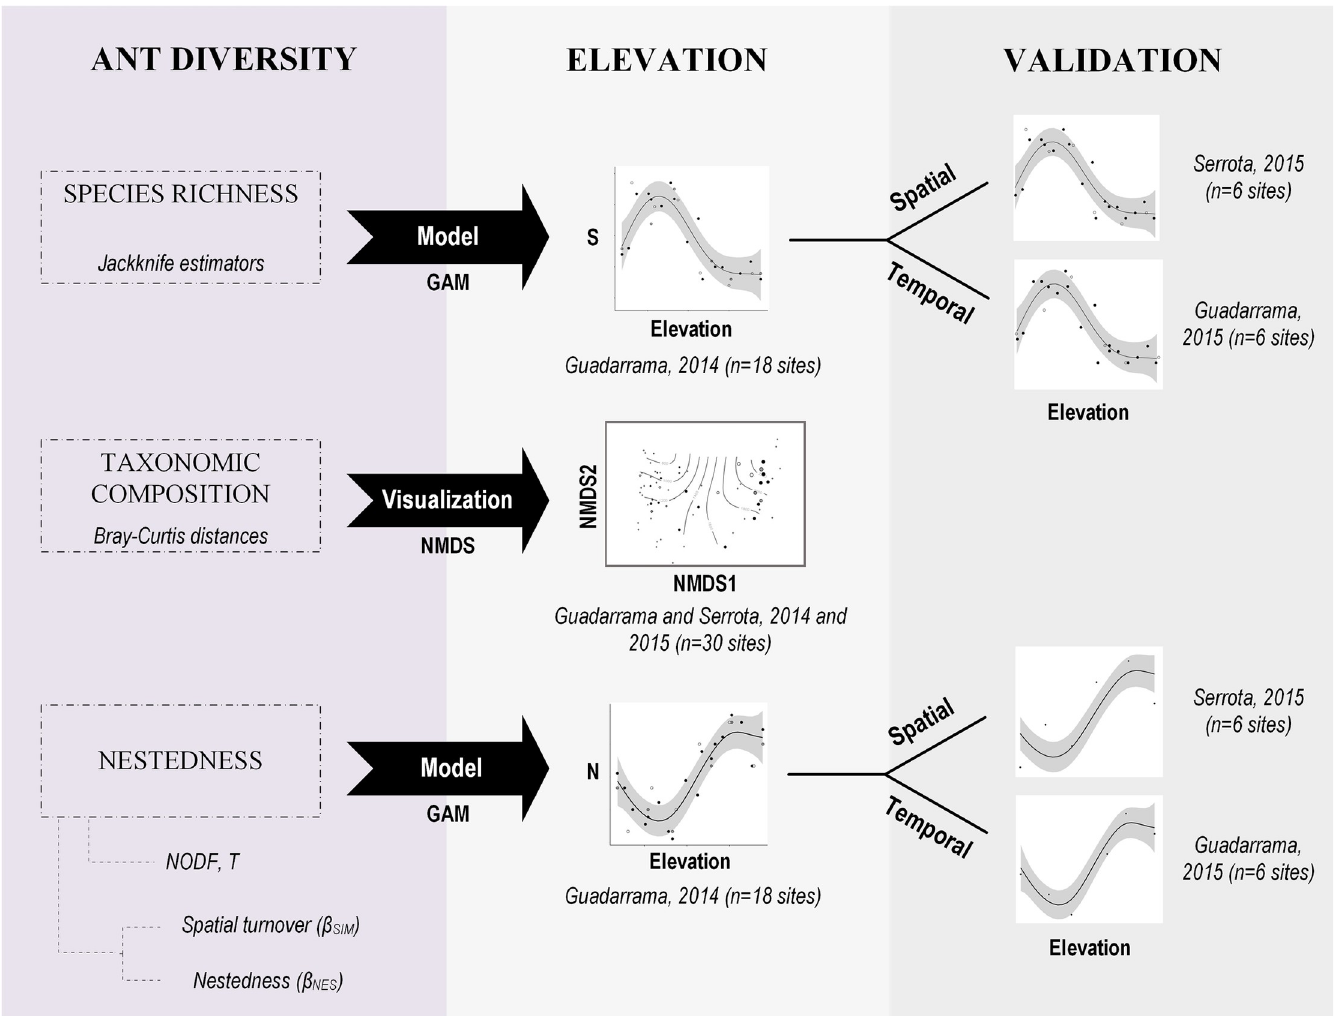
Fig 1. Analytical pathway followed in this study. Three elements of ant diversity were assessed along an elevational gradient in Guadarrama and Serrota mountain ranges in Central Spain: species richness (estimated with jackknife), taxonomic composition (described with Bray-Curtis distances) and nestedness (described by indexes of nestedness). The relationships of these elements to elevation was inspected with ordination (non-metric multidimensional scaling) and models (generalized additive). Models were built with the primary dataset obtained in Guadarrama in 2014 and their predictions evaluated with smaller validation